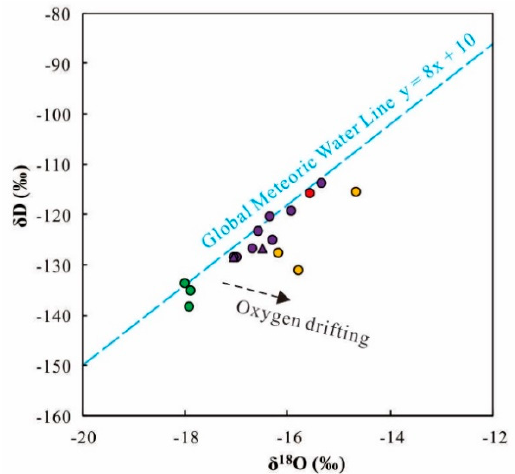
Figure 11. Plot of δ 18 O– δ D for the geothermal waters in the XFZ. Global meteoric water line (GWML) is after [33]. Legends follow those in Figure 5.